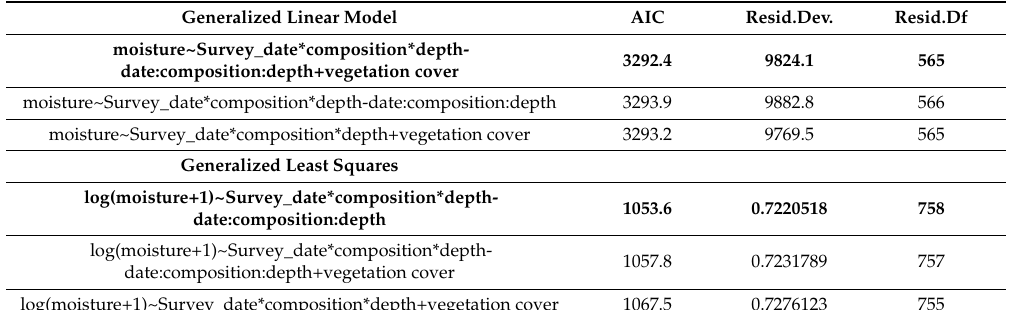
Table 2. Selection of variables used to choose the models. Model in bold is the one finally selected for this study. Resid.DF are the residual degrees of freedom and Resid.Dev is the residual